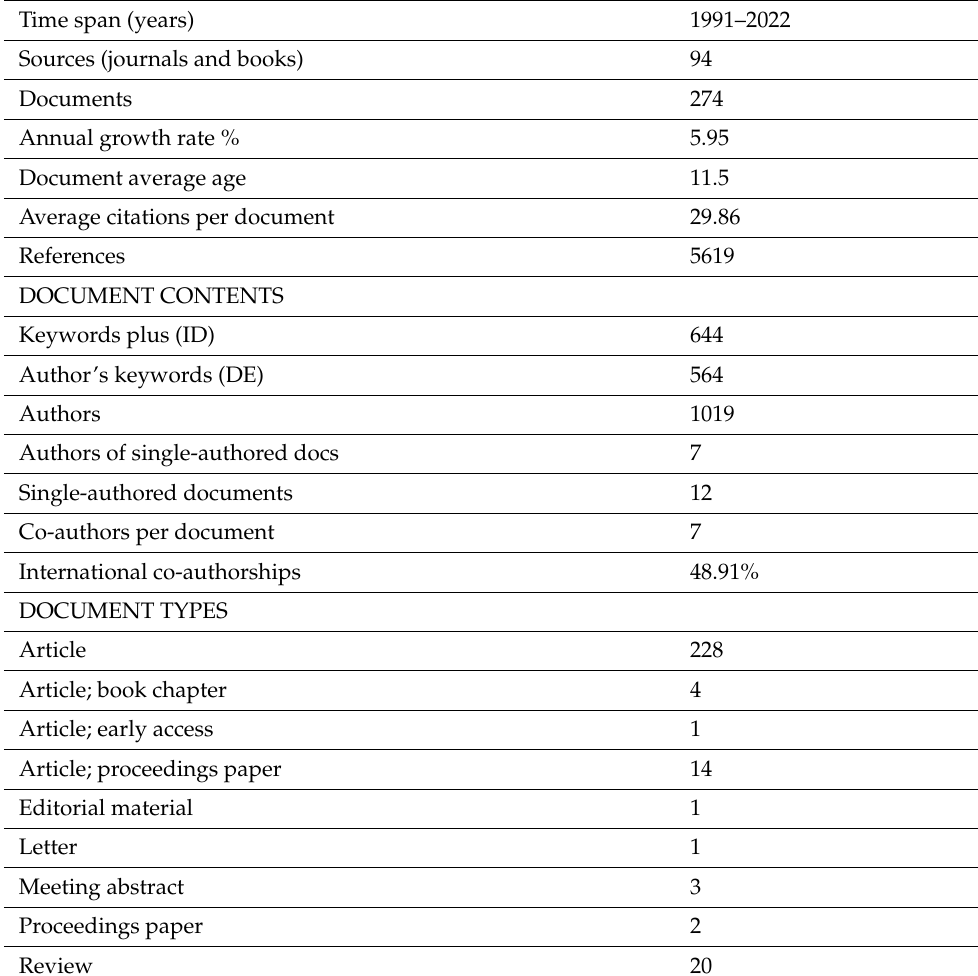
Table 1. Summary of information about the sources and papers used for this study. Left column indicates the items summarized in this